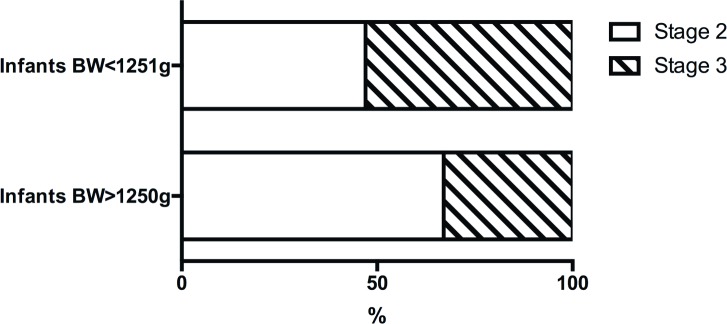
Comparison of Type 1 ROP stage between large and small preterm infants.The percentage of stage 3 ROP was significantly lower in large preterm infants than that of small preterm infants (33% vs. 53%, p = 0.007). BW: birth weight. Data source of infants BW < 1251 g: the ET-ROP study [10].